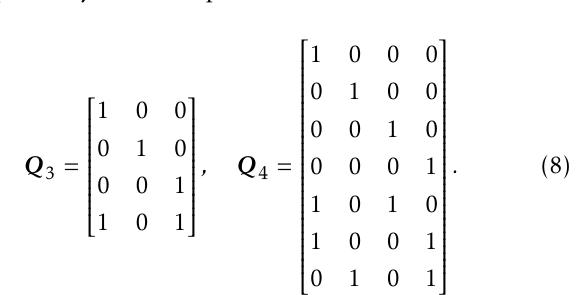
Table 1. Fibonacci sequence and